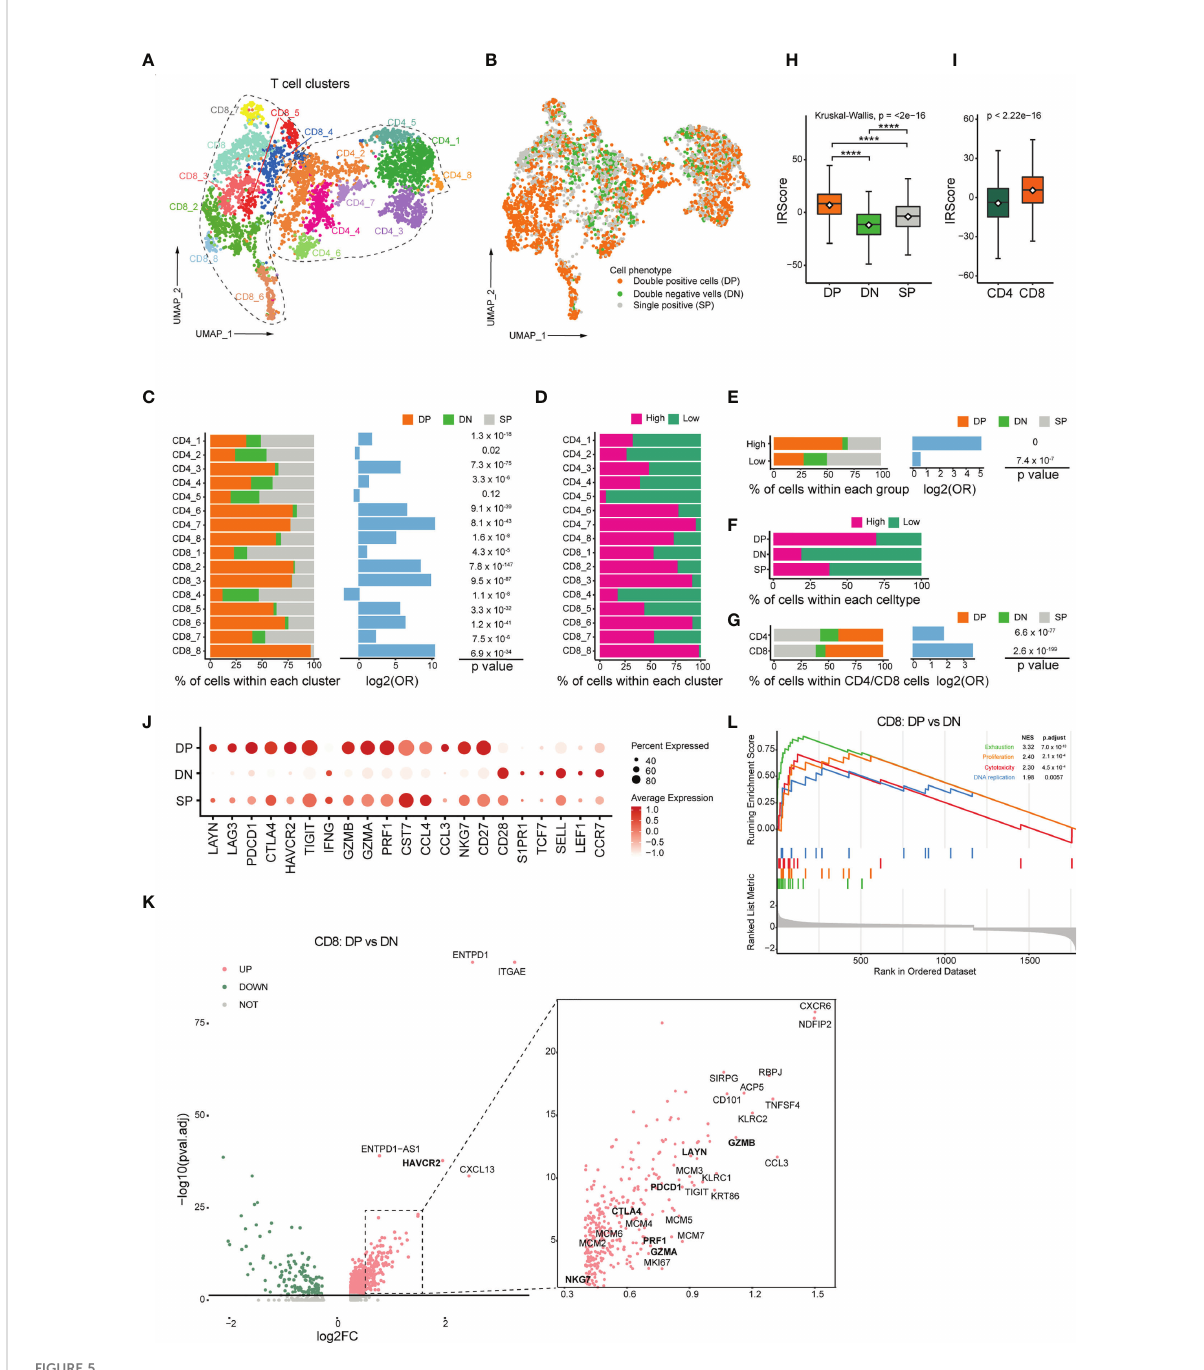
FIGURE 5 Transcriptomic pro fi les of CD103 + CD39 + T cells and association with IRScore. (A) UMAP projection of CD4 + and CD8 + TILs, showing 8 CD8 + clusters and 8 CD4 + clusters in different colors. (B) UMAP projection of CD103 and CD39 double-positive cells (DP), double-negative cells (DN) and single-positive cells (SP). (C) Stacked barplot showing the percentile of DP, DN and SP cells in each clusters (left), log2 odds ratio (DP versus DN, middle) and p value (right). (D) Percentile of high and low IRScore TILs in each cluster. (E) Stacked barplot showing the percentile of DP, DN and SP cells in high and low IRScore groups (left), log2 odds ratio (DP versus DN, middle) and p value (right). (F) Percentile of high and low IRScore TILs among three cell types. (G) Stacked barplot showing the percentile of DP, DN and SP cells in CD4 + and CD8 + TILs (left), log2 odds ratio (DP versus DN, middle) and p value (right). (H) Comparison of IRScore among DP, DN and SP cells. (I) Comparison of IRScore between CD4 + and CD8 + TILs. (J) Dotplot showing expression of exhausted, cytotoxic and naive markers in DP, DN and SP cells. (K) Volcano plot of differentially expressed genes between CD8 + DP and DN cells. (L) Enrichment plot for the curated gene signatures in CD8 + TILs by GSEA. ****P <